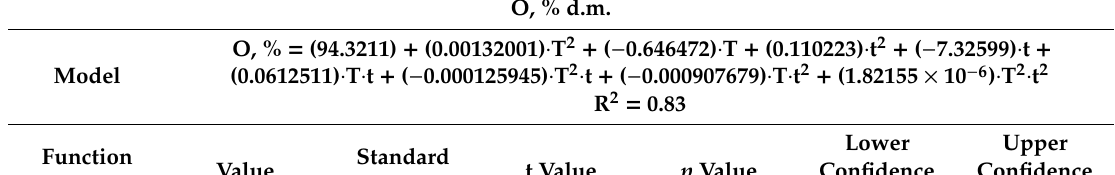
Table A8. The statistical parameters of polynomial regression analysis of the influence of SS torrefaction temperature and residence time on the O content in biochars.